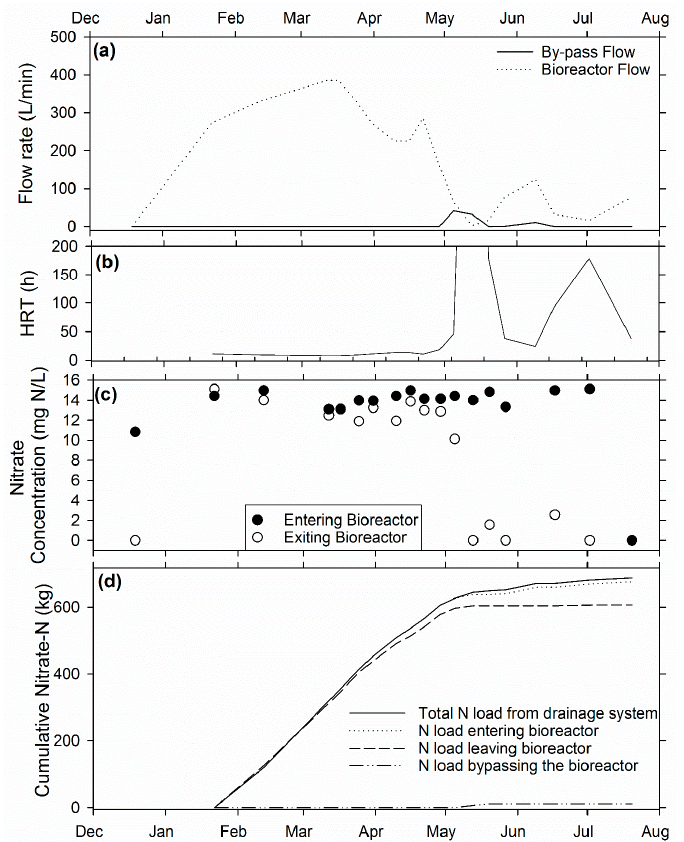
Figure 8. Voorhees Farm bioreactor and ( a ) bypass flow rate; ( b ) hydraulic retention time; ( c ) inflow and outflow nitrate concentrations; ( d ) and nitrate loadings from December 2014 to July 2015.